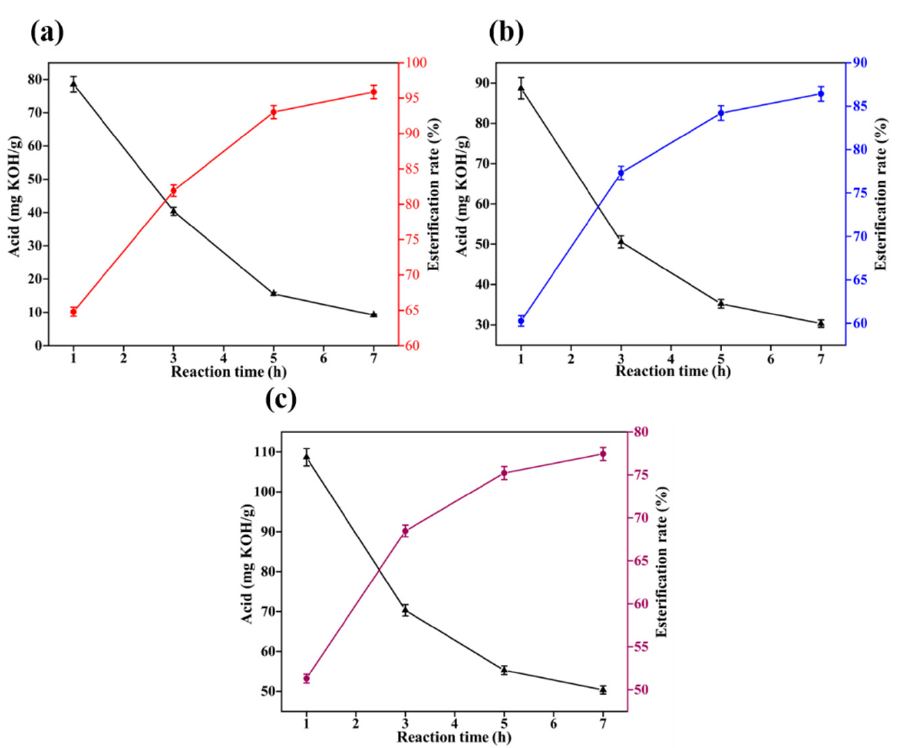
Figure 6. Catalytic esterification results of different catalysts ( a ): concentrated sulfuric acid; ( b ): sodium hydroxide; and ( c ): sulfamic acid.